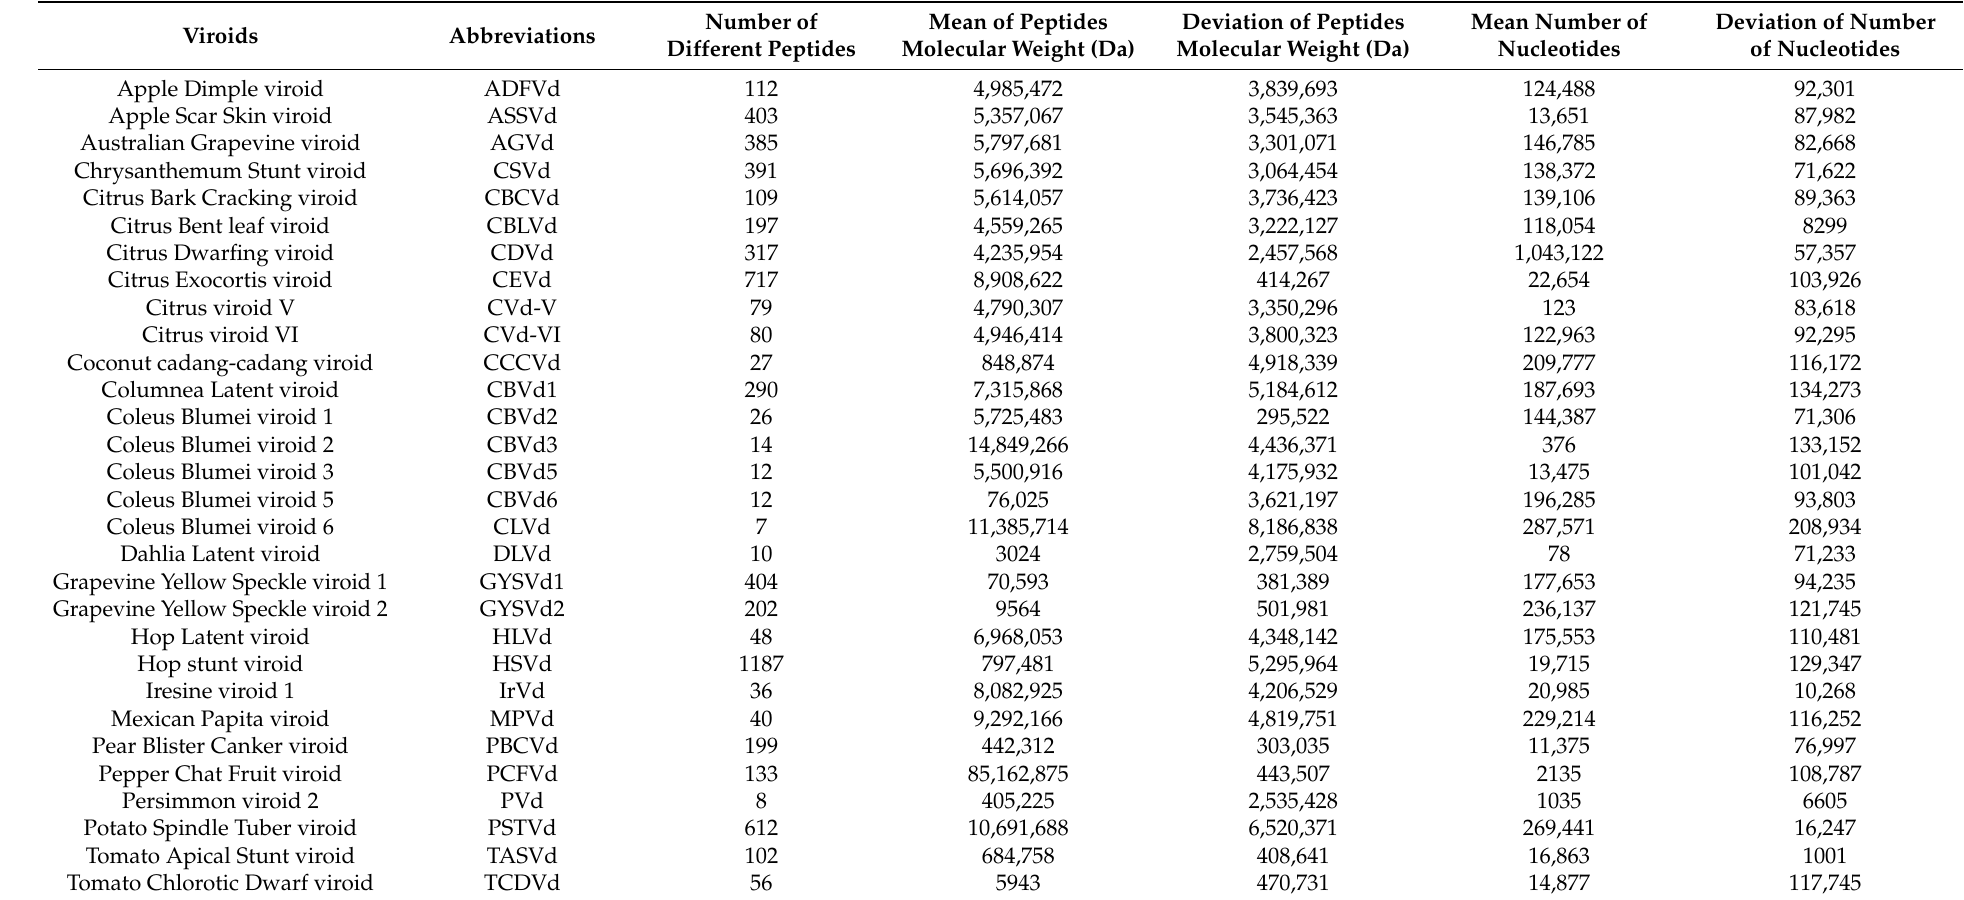
Table 1. Identified Small Peptides in